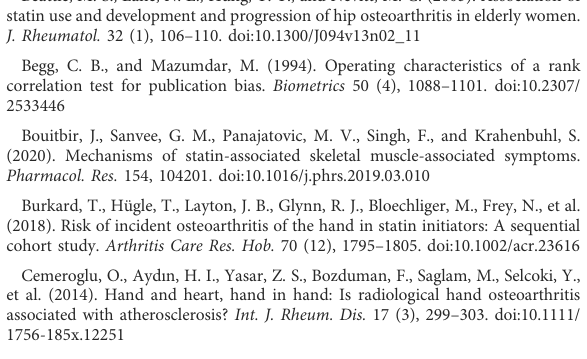
SUPPLEMENTARY FIGURE S1 Correlation analysis of statin use duration and dosage and OA risk. (A,B) display two kinds of duration descriptions of statin use. The horizontal coordinate indicates statin use duration, and the ordinate coordinate indicatestheORvaluesand95%CIsofstatinusersvs.nonusers.Statinuse dose-OA risk correlation analysis of (C) overall statin users and (D) statin users with antihypertensive drug use. The horizontal coordinate here indicates statin use dosage. No signi fi cant correlations and tendencies were